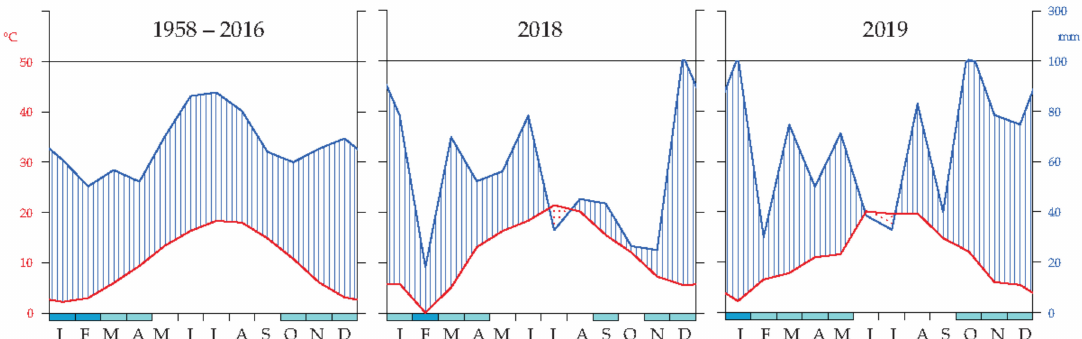
Figure 1. Walter–Lieth climate diagram from the German Weather Service (DWD) weather station (Cologne Bonn airport, station ID 2667) for the long-term average (1958–2016) and the sampling years 2018 and 2019.